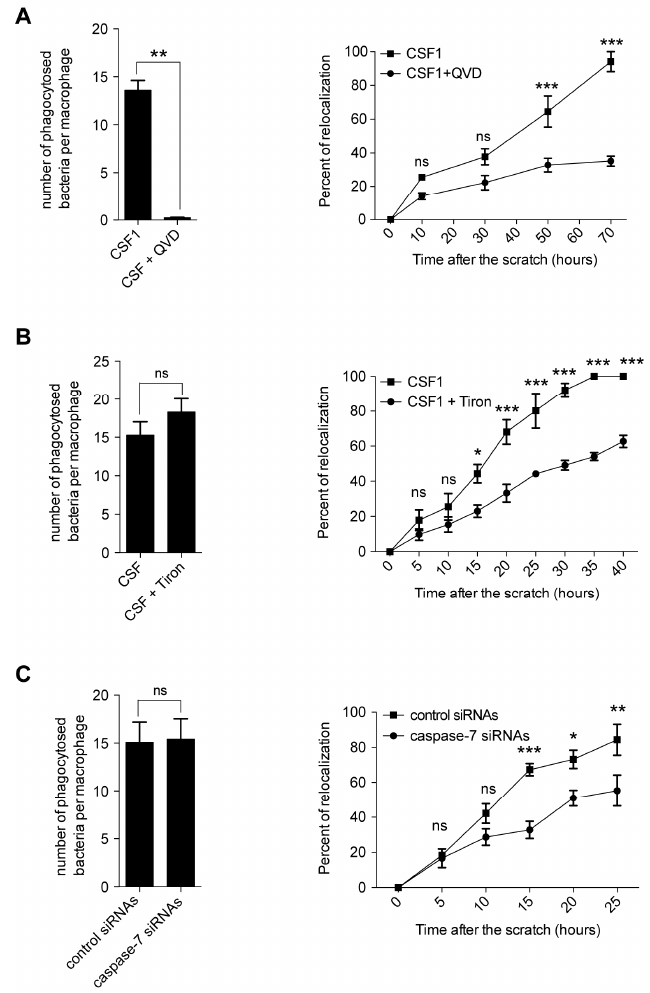
Figure 8. Caspase inhibition alters the migration of CSF1-induced macrophages. Bacterial uptake was measured by the gentamicin protection assay (left panels) and cell migration was studied using a wound-healing assay (right panels) in monocytes treated for 4 days with CSF-1, with or without 50 µM Q-VD-OPh ( A ), 500 µM Tiron ( B ), or a pool of scrambled or caspase-7 targeting siRNAs ( C ). Mann–Whitney test was used to compare the number of phagocytosed bacteria, and two-way ANOVA with Bonferroni post-test was used for the wound-healing assay (*, p < 0.05; **, p < 0.01; ***, p < 0.001; ns, non-significant). Mean ± SE.